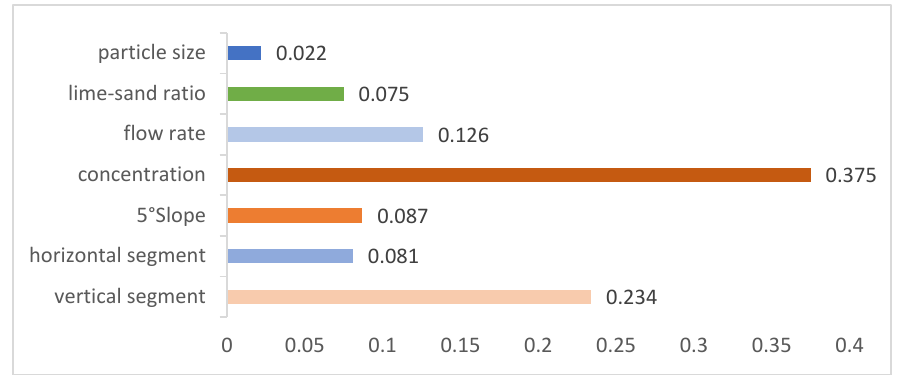
Figure 4. Test variable correlation score map. The abscissa is the weight, and the ordinate is the